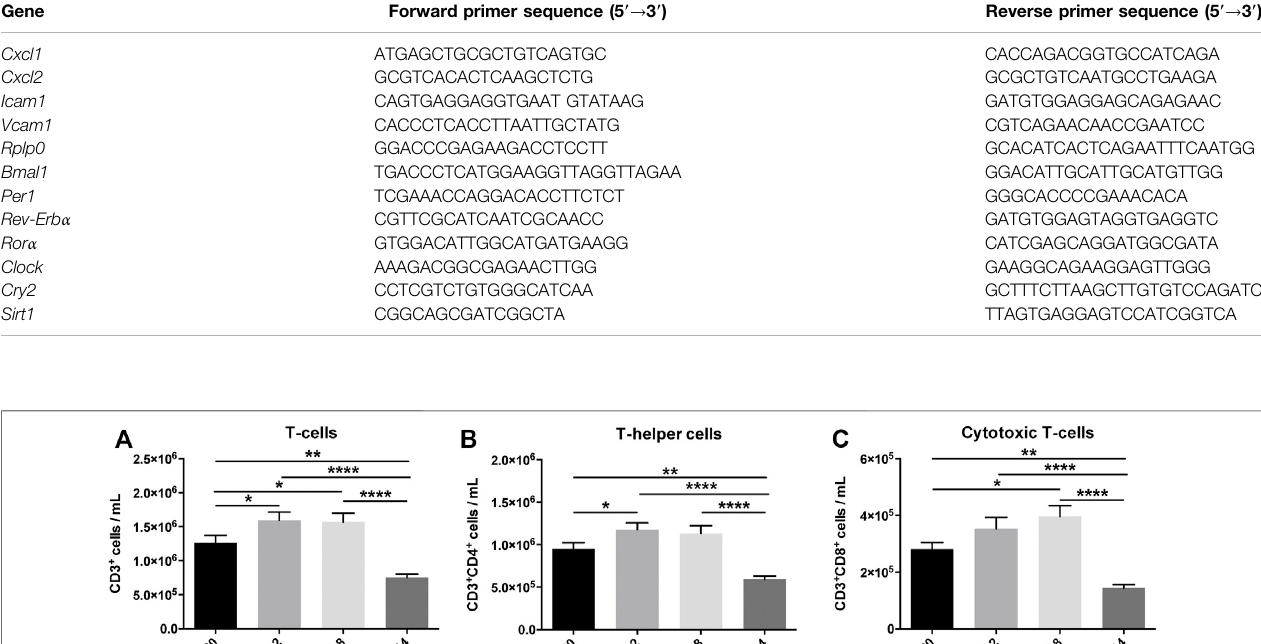
TABLE 1 | List of RT-qPCR primers. Gene